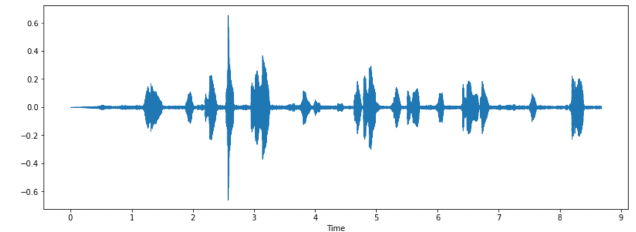
Figure 10: Audio waveform of Canada Goose